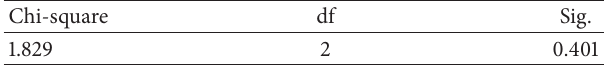
Table 1: Results of the Hosmer-Lemeshow